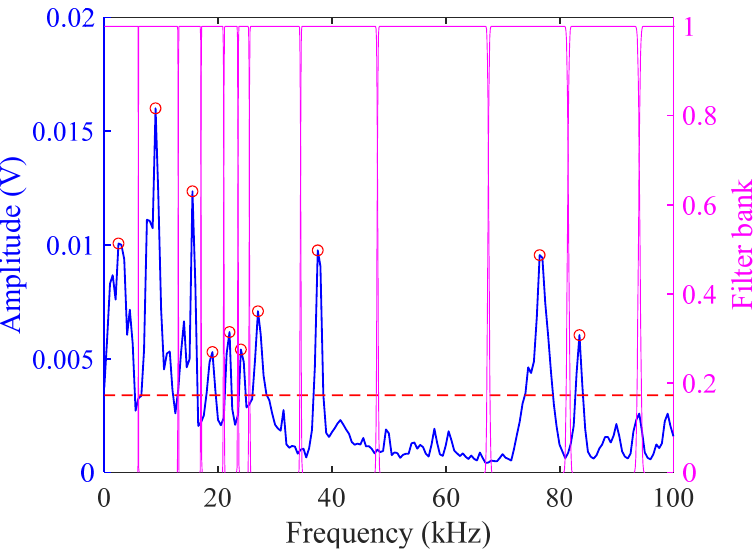
Figure 8. Adaptive segmentation result of the Fourier axis based on STFT and closing operation.